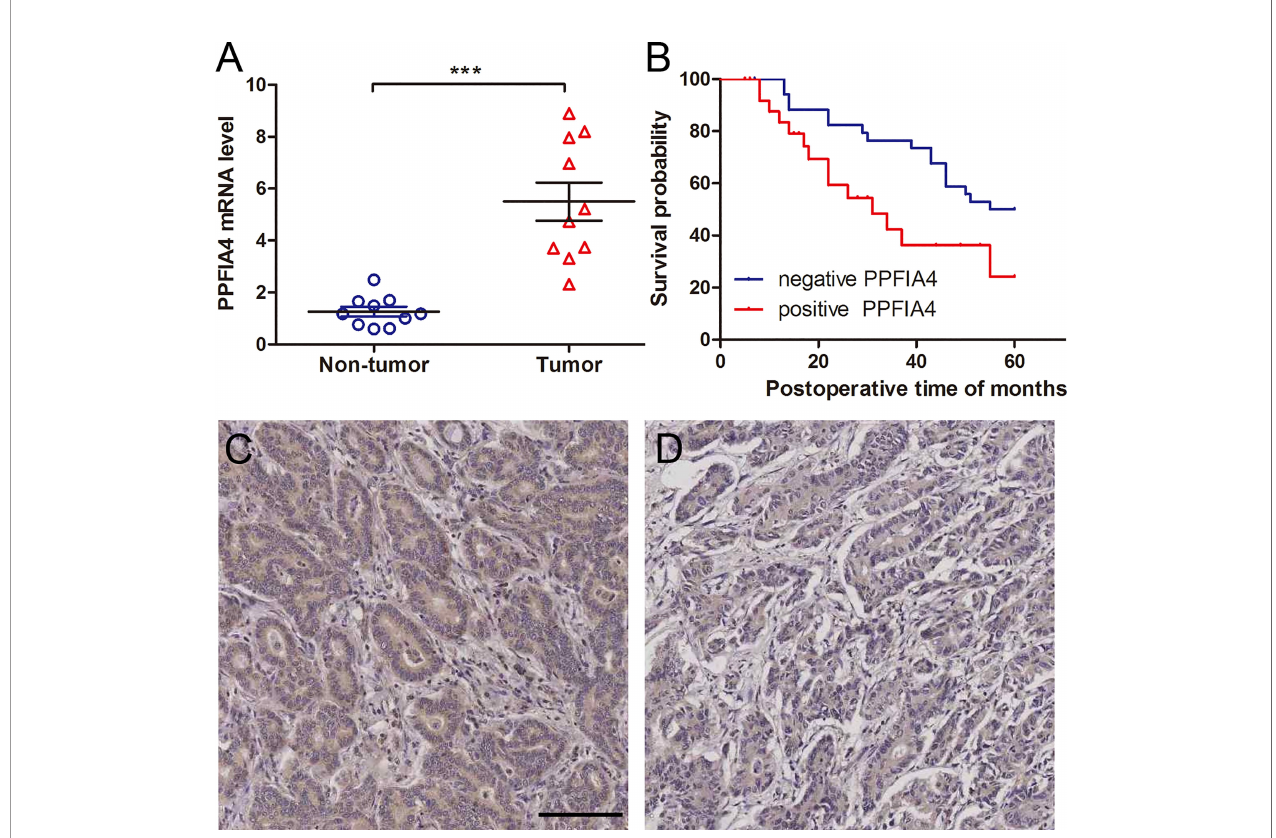
FIGURE 7 | PPFIA4 expression is signi fi cantly upregulated in cholangiocarcinoma tissues. (A) PPFIA4 mRNA levels were determined by RT-qPCR in 10 pairs of cholangiocarcinoma tissues and matched non-tumor tissues. NT, tumor adjacent non-tumor tissue; T, tumor. ***p-value < 0.001. (B) OS curves of cholangiocarcinoma patients with different PPFIA4 expression. (C) Representative IHC images of positive PPFIA4 expression. (D) Representative IHC images of negative PPFIA4 expression. Scale bar, 100